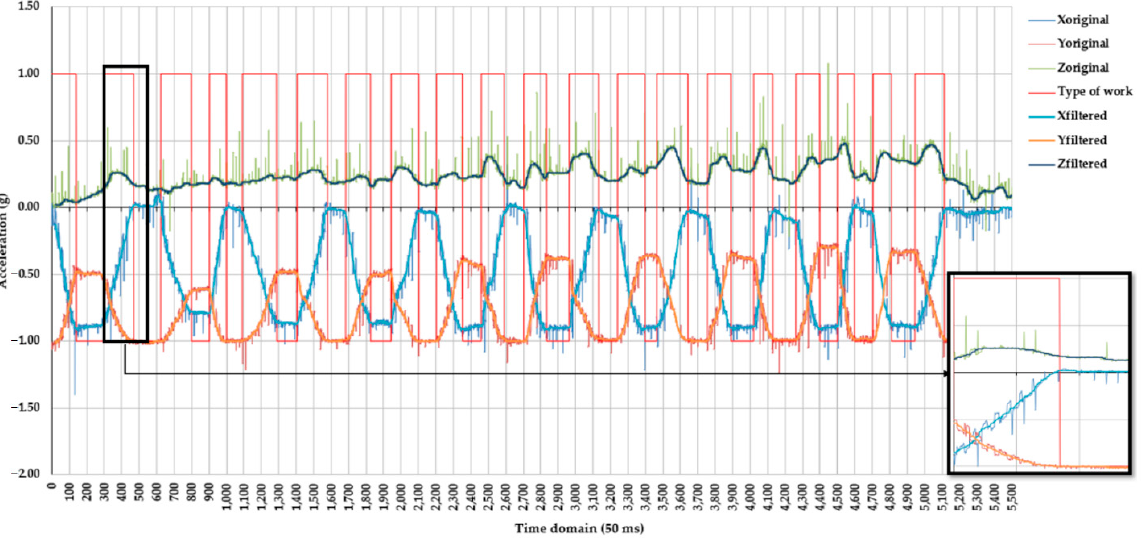
Figure 4. Effect of axial signal filtering by a median filter with a window size of 41. Legend: Xoriginal, Yoriginal, and Zoriginal are the original values collected by the accelerometer on the x, y, and z axes, respectively; Xfiltered, Yfiltered, and Zfiltered are the values of the signals on the three axes after applying a median filter with a window size of 41; type of work is an arbitrary signal taking a value of 1 when dynamic work (movement) was present and − 1 when static work (no movement) was present. Note: the time domain from 0 to ca. 5100 (50 ms increments) corresponds to the subprotocol A1 (Table A1), and the time domain from ca. 5100 to 5500 (50 ms increments) (right part of the figure) corresponds to keeping an orthostatic posture before starting subprotocol A2; details given in black box indicate the utility of the used median filter in removing both impulse noise and oscillations during dynamic work.